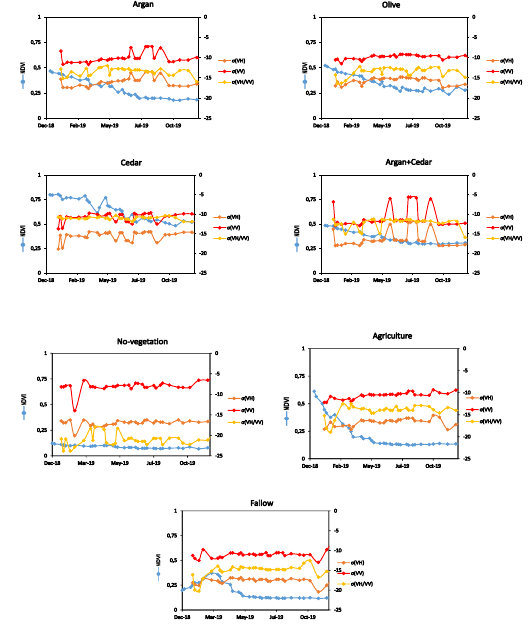
Figure 3 . NDVI, σ(VV), σ(VH) and σ(VH/VV) profiles of the different classes selected in the study area for